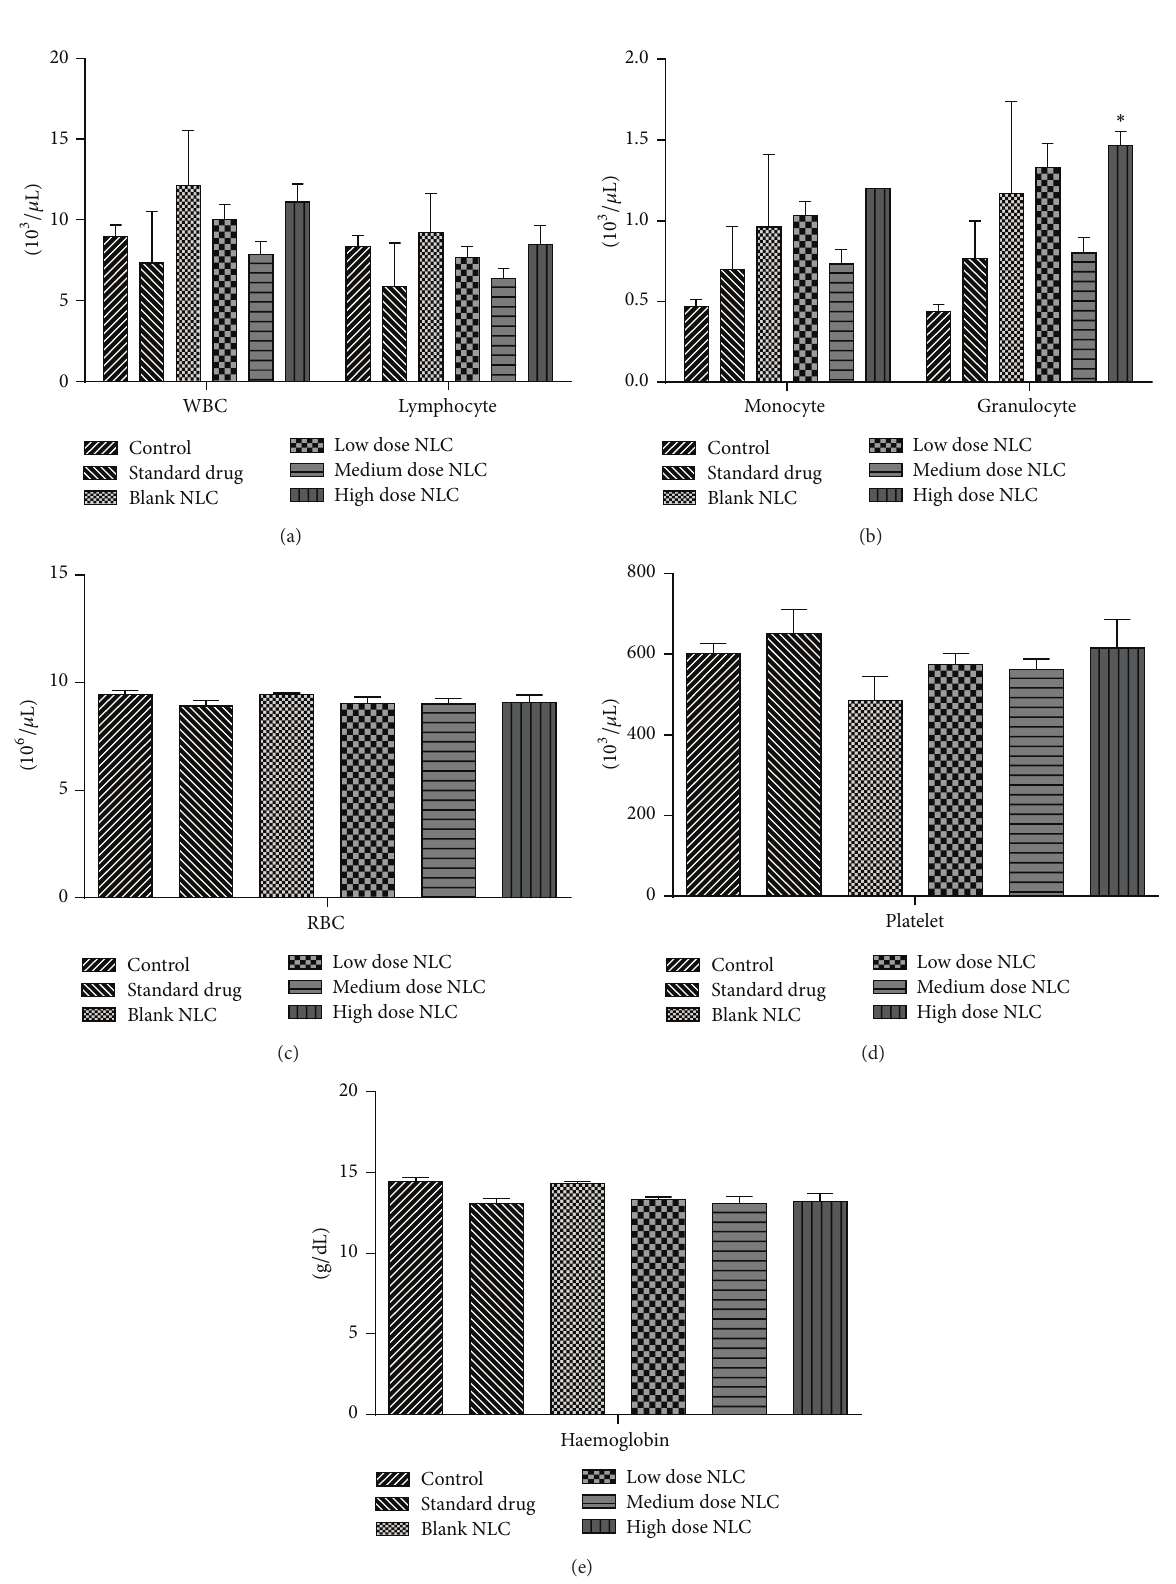
Figure 5: (a, b, c, d, and e) Hematological count of female rats treated with NLCs formulation. All the values are represented as mean ± SEM and 𝑛 = 5 . ∗ 𝑝 < 0.05